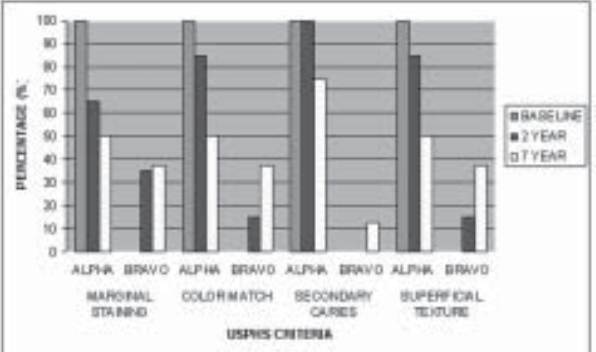
Fig. 1 - Frequency distribution of USPHS